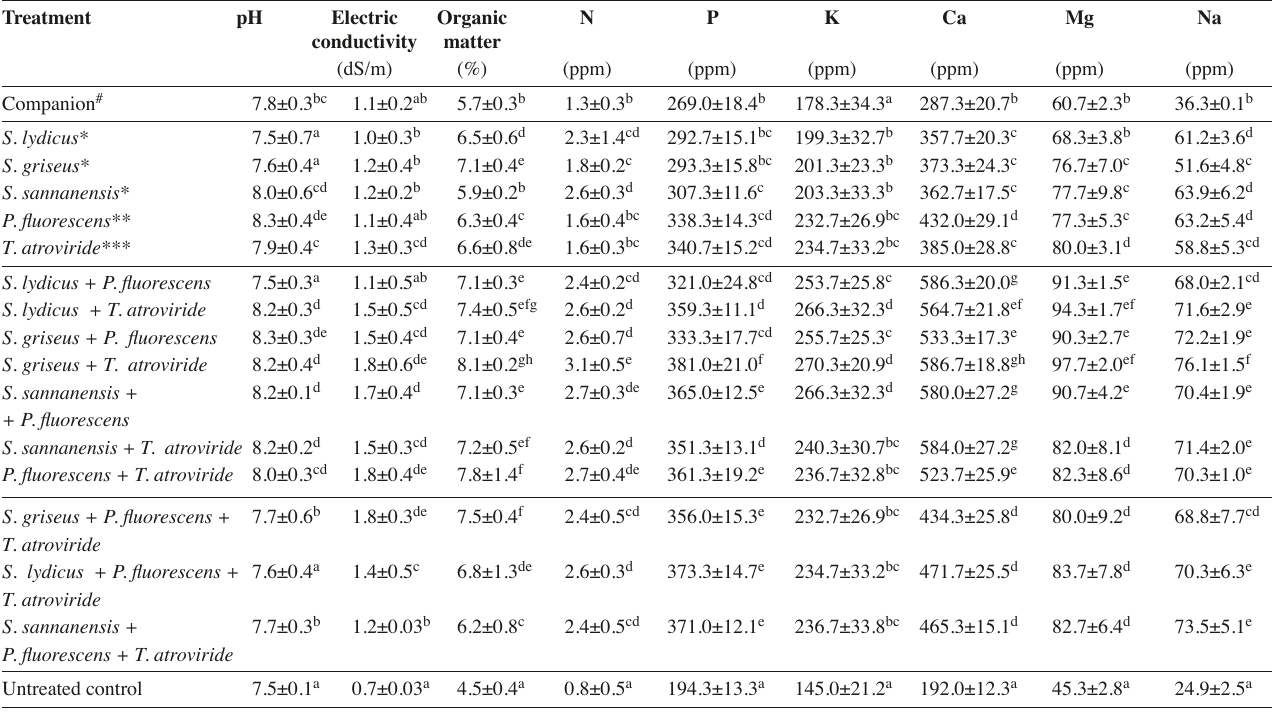
Tab. 6: Effect of various biocontrol agents application on nutrient status of turmeric soils